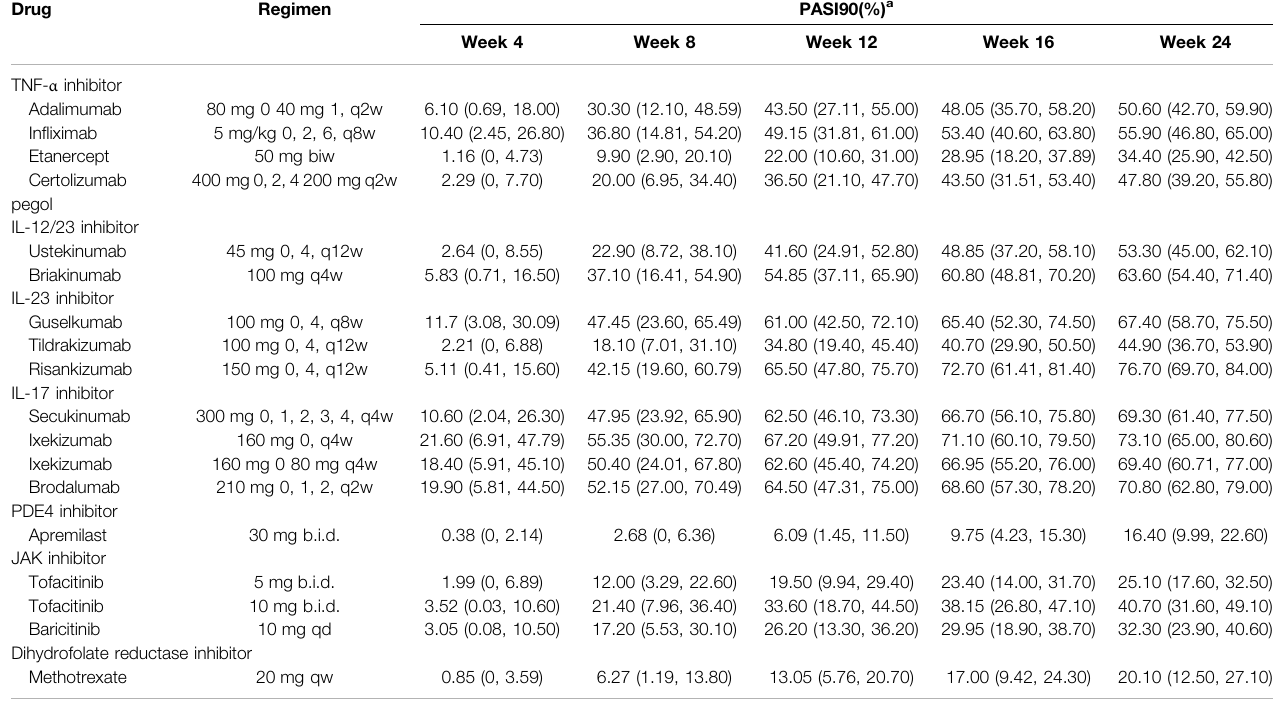
TABLE 5 | Model predicted PASI90 response of treatments at different time